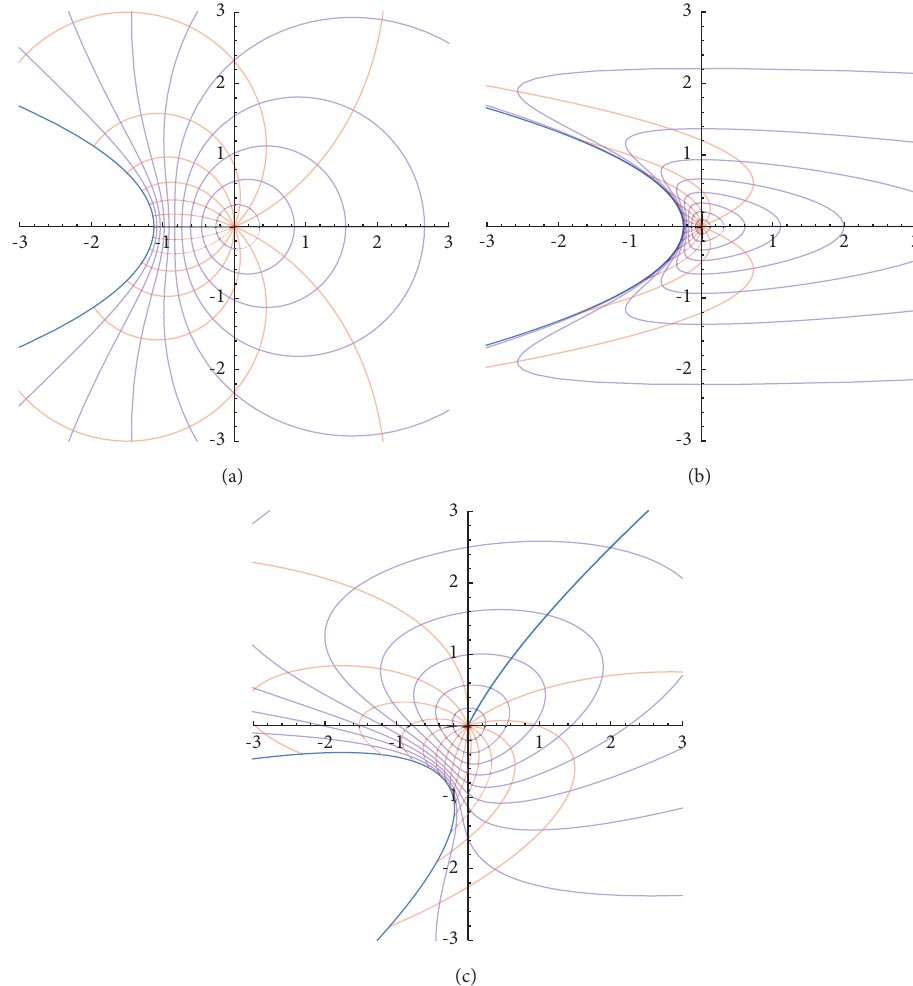
Figure 1: Images of D under f